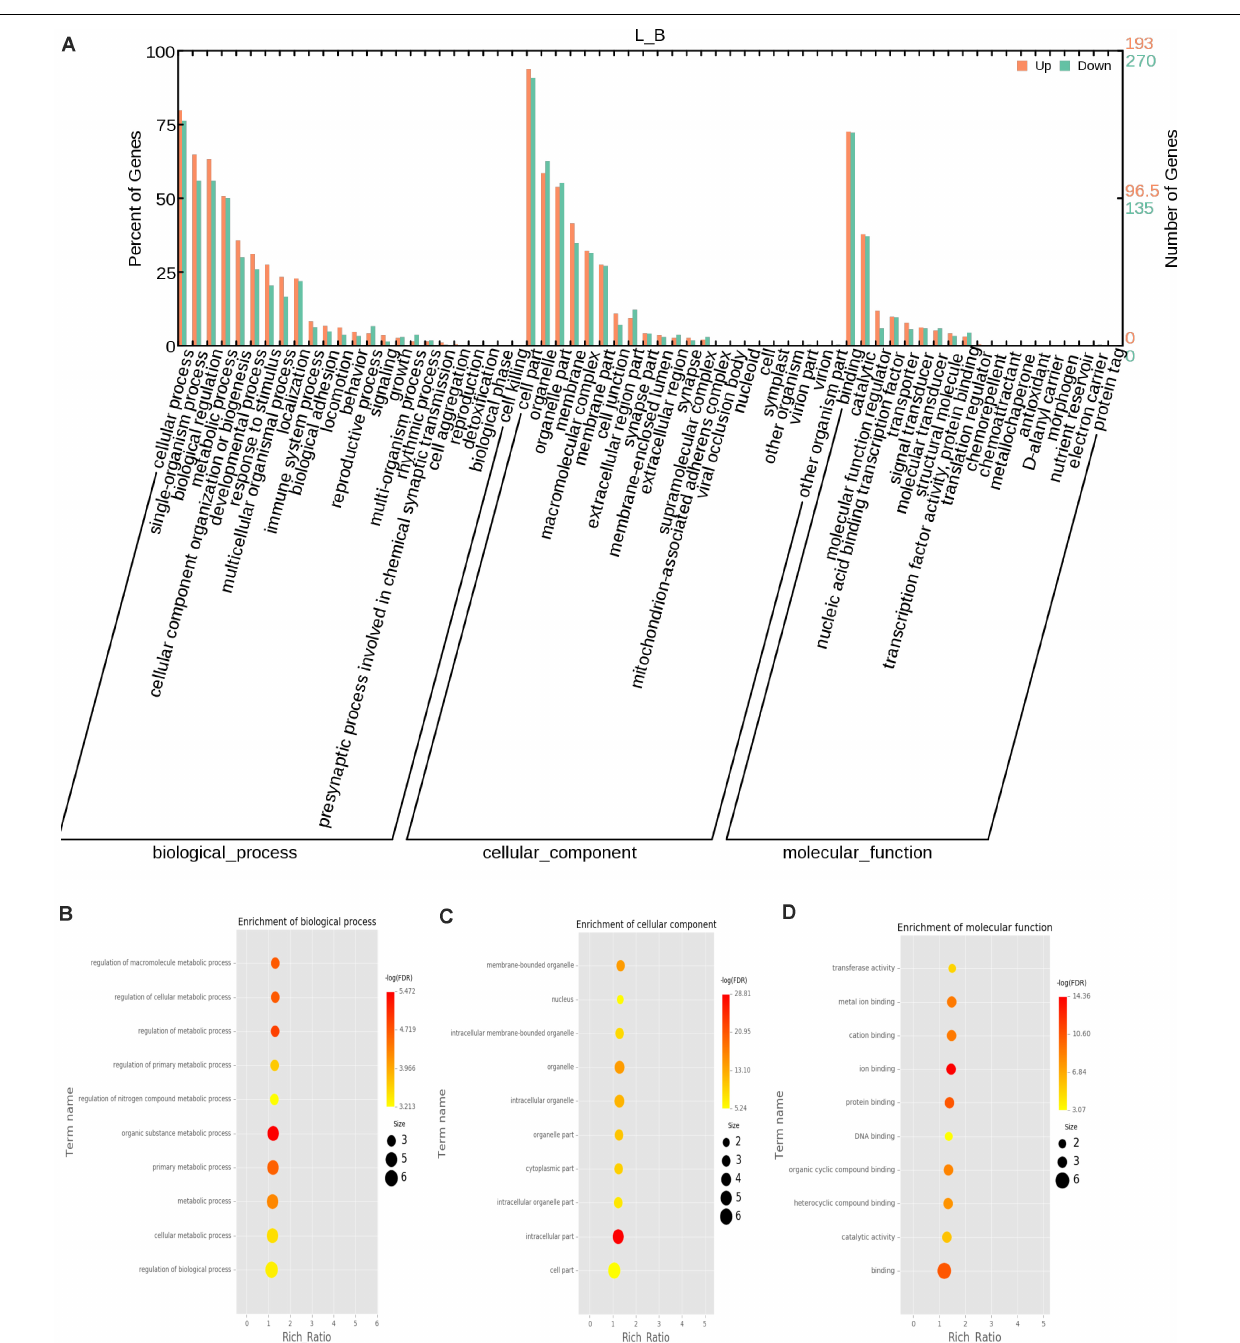
of the control group ( P < 0.01), but the luciferase activity of the mutant vector and bta-miR-1 co-transfected group was not significantly different from that of the control group, indicating that circ0014518 has a bta-miR-1 binding